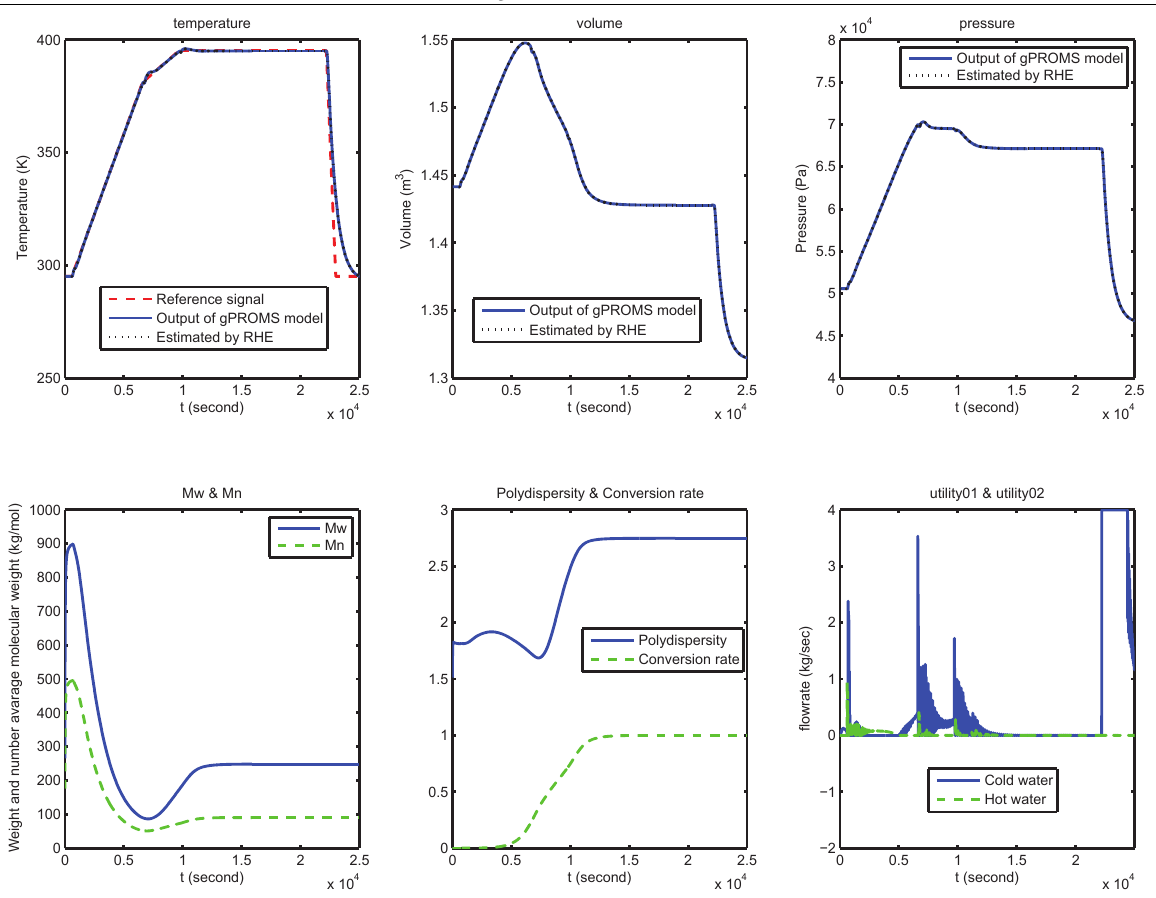
Figure 1: Tracking result of the explicit MPC with explicit